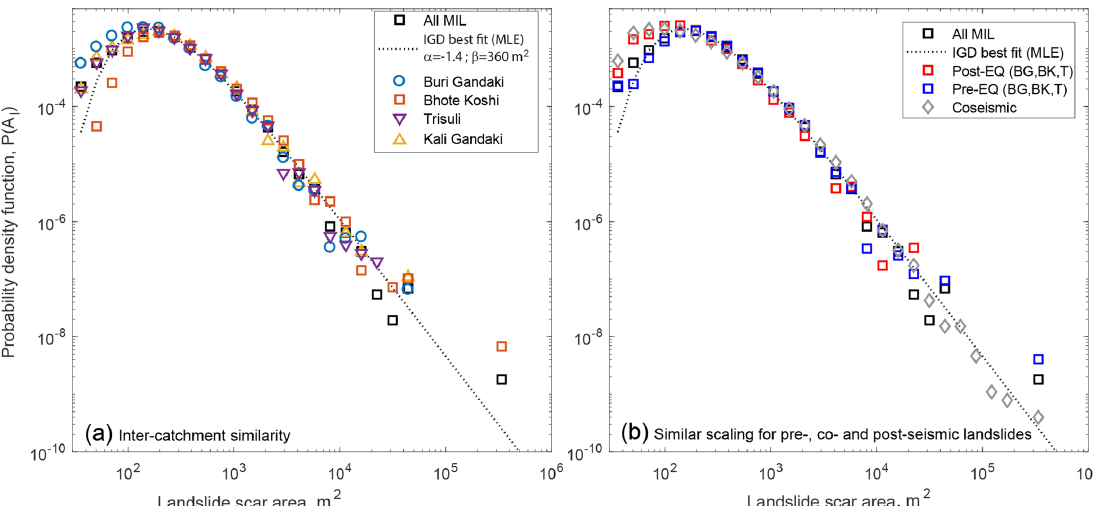
Figure 3. Probability density functions of landslide scar area for different landslide populations. In both panels, black squares are for the monsoon-induced landslides (MILs) mapped in the four RapidEye tiles in the period 2010–2017 and dotted curves show the same best-fit associated inverse gamma distribution (IGD), with the two parameters given in the inset. In (a) , data are subdivided by mapping area. In (b) , the coseismic landslides (from Roback et al., 2018) normalized for run-out, are in grey, while landslides from the monsoon 2010–2014 and 2015 in the Buri Gandaki, Bhote Koshi and Trisuli mapping areas are in red and blue, respectively.